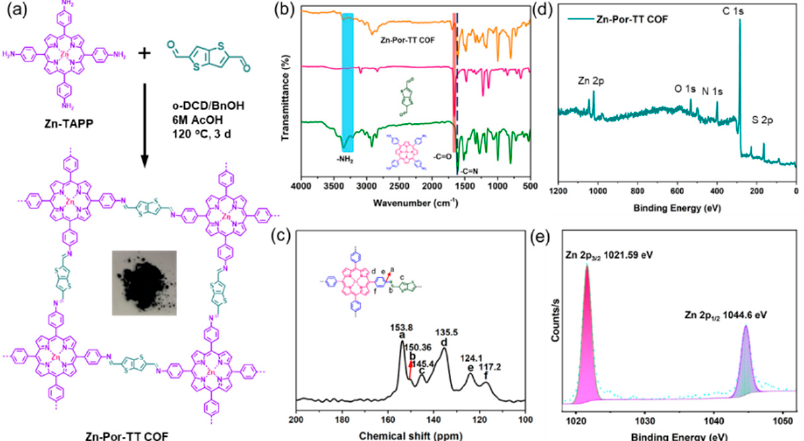
Figure 1. ( a ) Synthetic diagram of Zn-Por-TT COF; ( b ) FT-IR spectra of Zn-Por-TT COF (orange), TT (pink), Zn-TAPP (green); ( c ) 13 C CP-MAS NMR spectrum of Zn-Por-TT COF; ( d ) XPS of Zn-Por-TT- COF; and ( e ) high-resolution XPS spectrum of Zn.